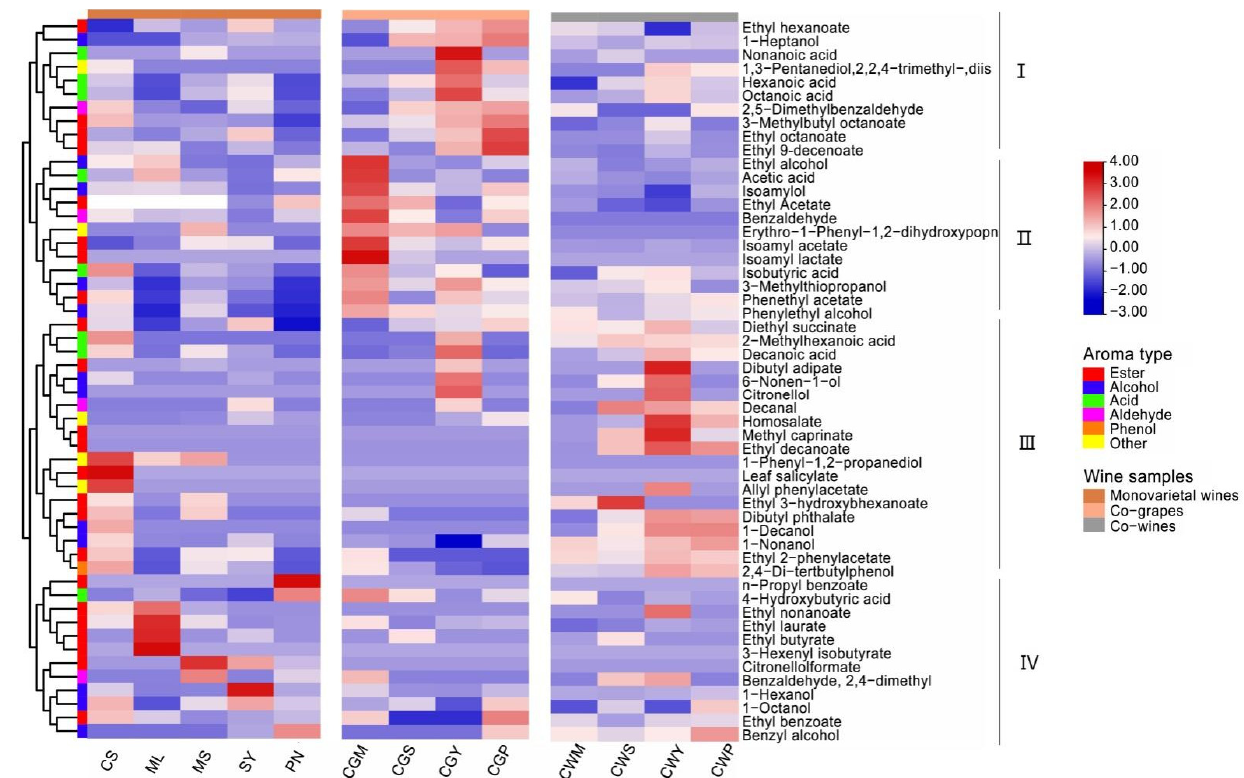
Figure 8. Heatmap cluster analysis of wine samples with different varieties and blending methods.